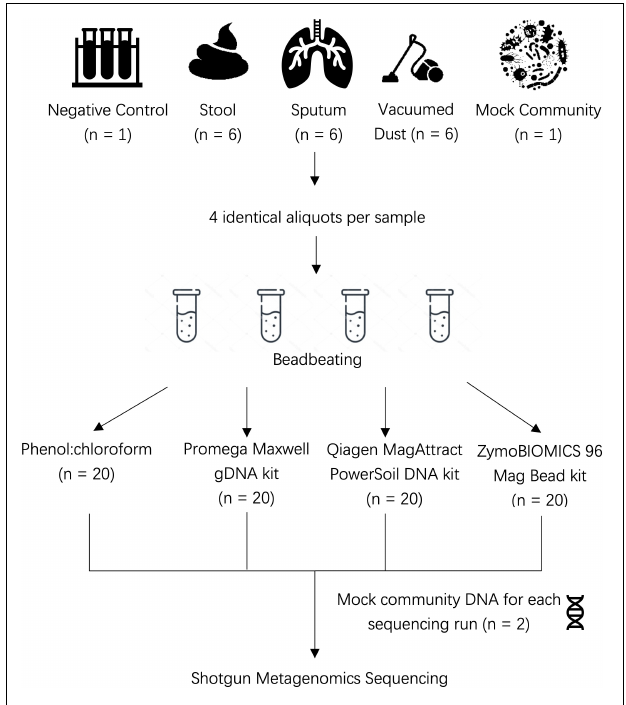
FIGURE 1 | Overview of study